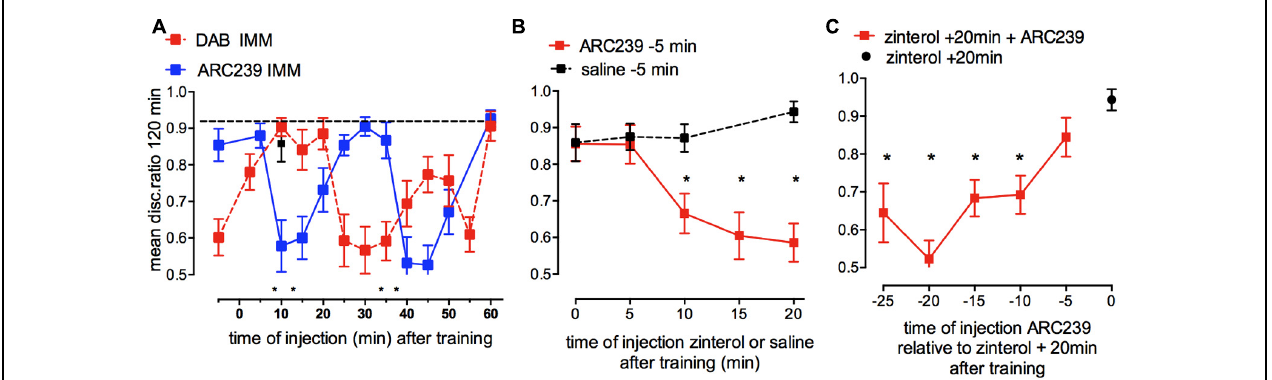
FIGURE 8 | Effect of inhibition of glycogen re-synthesis by the α 2B / C -AR antagonist ARC239 on strongly reinforced memory and challenges to inhibition of re-synthesis by β 2 -AR stimulation (glycogen breakdown) and vice versa. (A) ARC239 was injected into IMM at different times after training. The timing of the effect of ARC239 is compared with that of DAB (From Gibbs et al., 2008b; Hertz and Gibbs, 2009). (B) ARC239 or saline were injected 5 min before weakly reinforced training and zinterol injected into different groups at various times after training. Inhibiting re-synthesis of glycogen prevented β 2 -AR stimulation from promoting memory consolidation up to 10 min prior to zinterol injection. Normal learning is indicated by black squares. (C) Zinterol was injected into all groups 20 min after weakly reinforced training and ARC239 had been injected at times from 25 to 5 min before zinterol (i.e., from 5 min before to 15 min after training). * P < 0.05. (From Gibbs and Hutchinson, 2012).